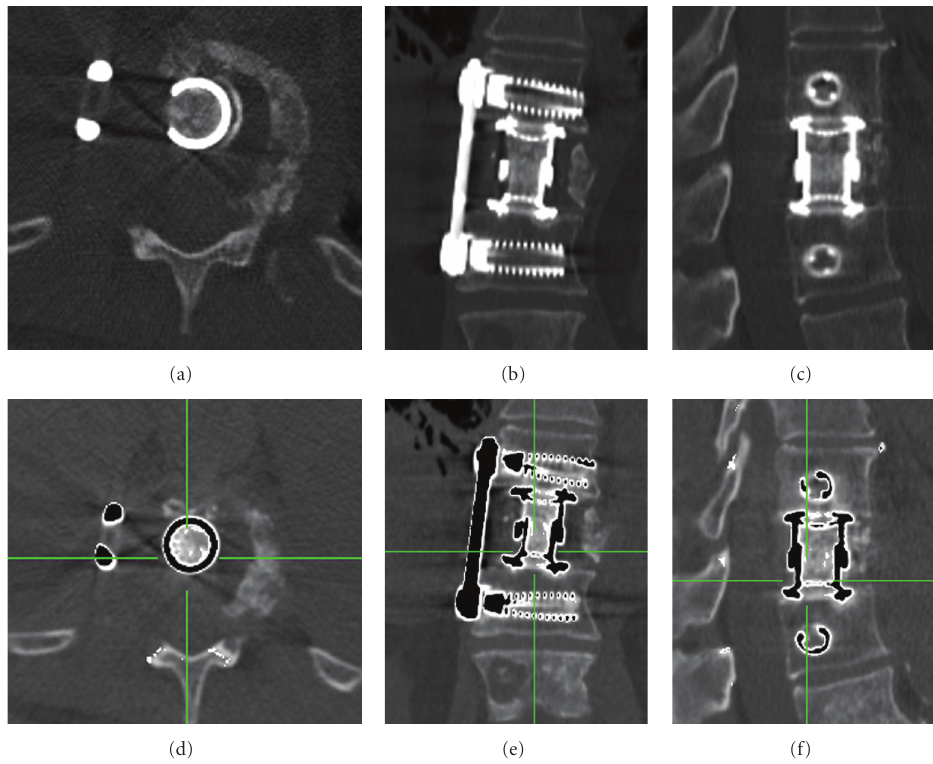
Figure 1: Case 1: 79-year-old man with metastatic leiomyosarcoma to the T11 vertebral body, s/p vertebrectomy, and reconstruction. (a, b, c). Axial, coronal, and sagittal MDCT. The position of the expandable titanium cage and anterior thoracic fusion plate is demonstrated. (d, e, f). Co-registration of sequential MDCT studies. The original study is in white color and the more recent study is in black color; a similar position of the surgical instrumentation between the two sequential studies is demonstrated. Green line denotes corresponding position of the other two orthogonal